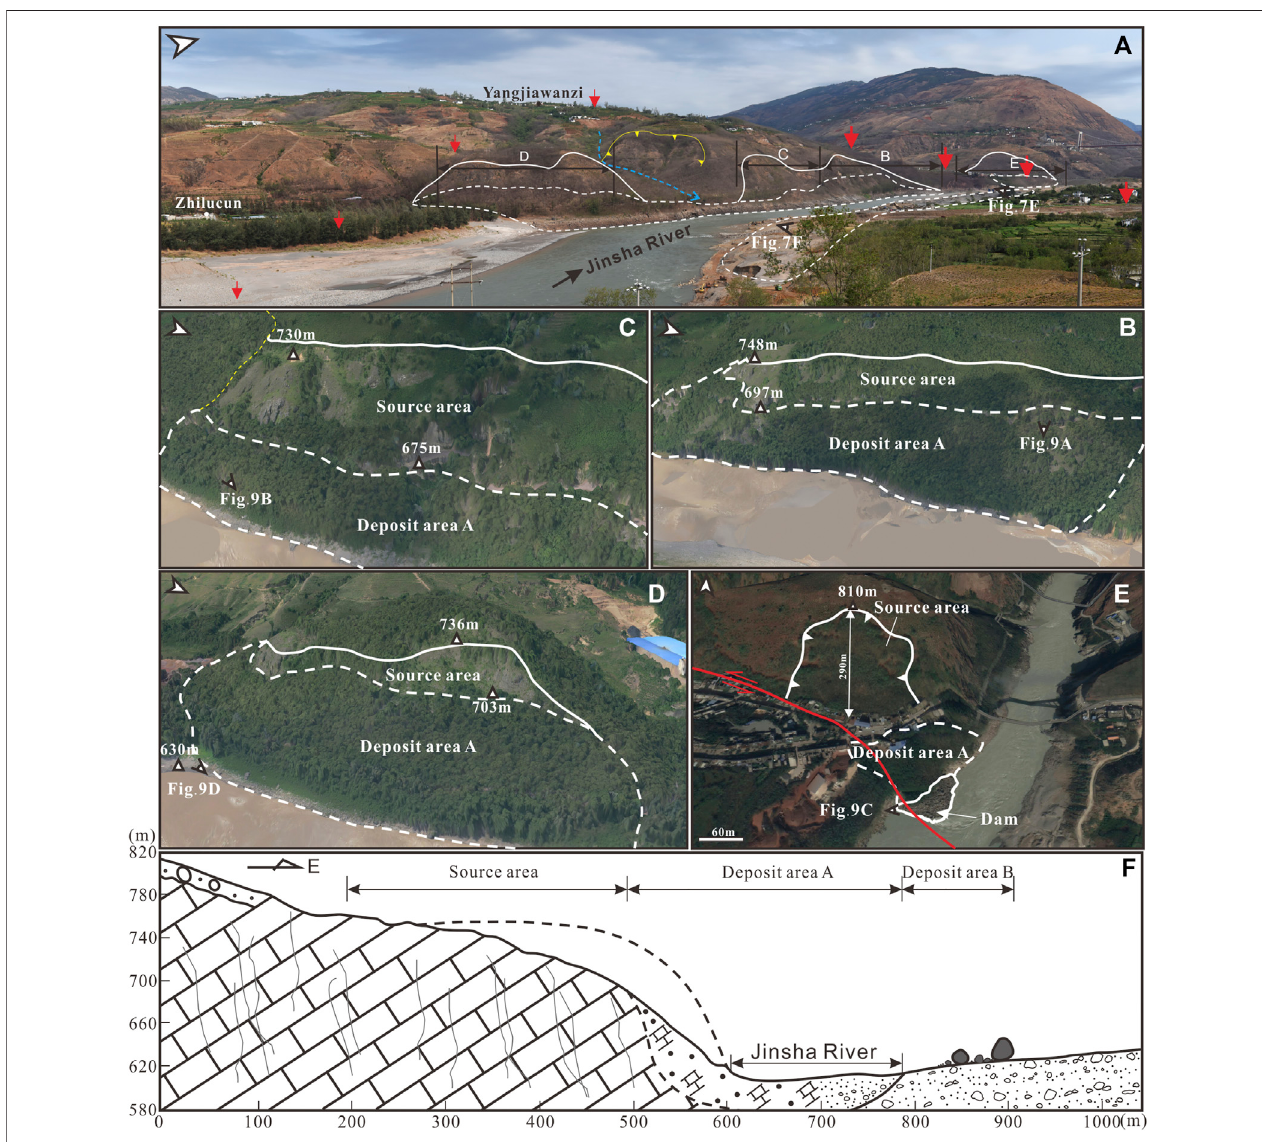
FIGURE 8 | Landslide morphology (A) Field panoramic photo of the failed slope collapse (location in Figure 3 ). Source area, deposit area, and boulders are indicatedwithwhitesolidlines,andwhitedashed line,respectively.Yellowjagged lineshowsthecrownoftheearlylandslides,aswellasthegullyandvillageswithablue dashed lineand white/blacksolidcircles.The QiaojiaSegment and thepreviousQiaojiaSegmentareindicatedwithlarger redarrows and smaller red arrows. (B) – (D) Air photos show the details of the failed slope collapse at different sections. The elevations of the crown and the foot of the source area are marked. (E) Google Earth Image of the rock fall located at the north side of Qiaojia Segment; the crown elevation of the source area and the maximum travel path of the deposit are indicated; the dam, which is inside the range of the Jinsha River, is also circled with a white solid line. (F) Longitudinalpro fi le ofthe failed slope collapse, and the location is in Figure 3 .